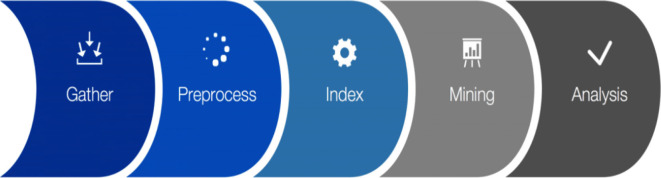
The steps involved in a text mining process (Kaur and Singh, 2019).